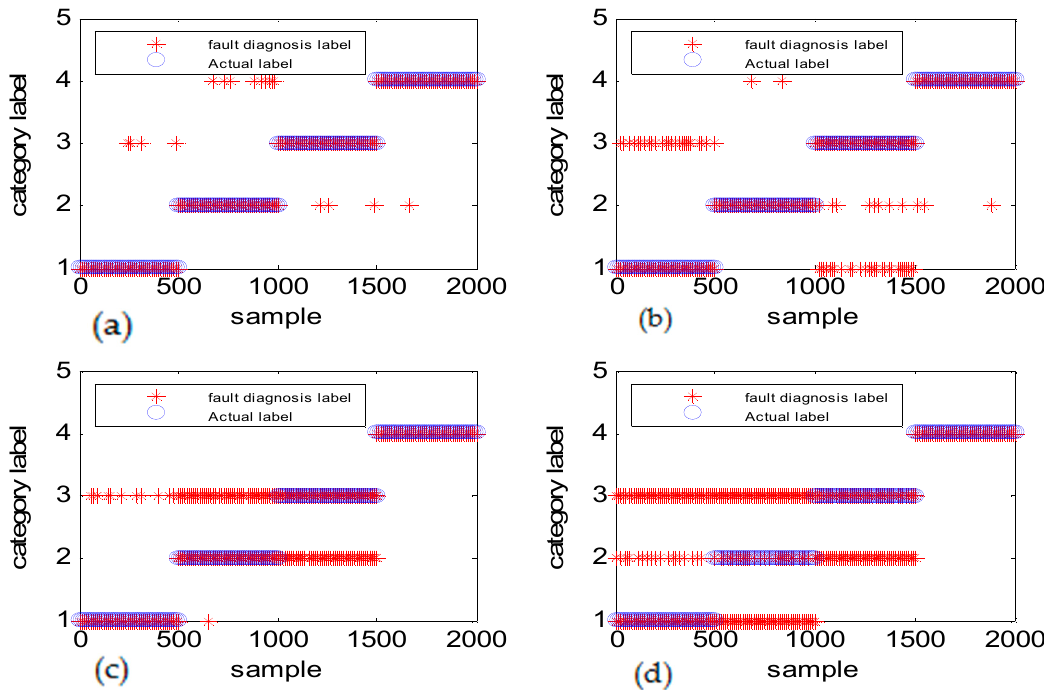
Figure 21. Benchmark test for the diagnosis of the same fault with different sizes: ( a ) DGFFDNN, ( b ) DNN, ( c ) DGFFBP, and ( d ) BP.